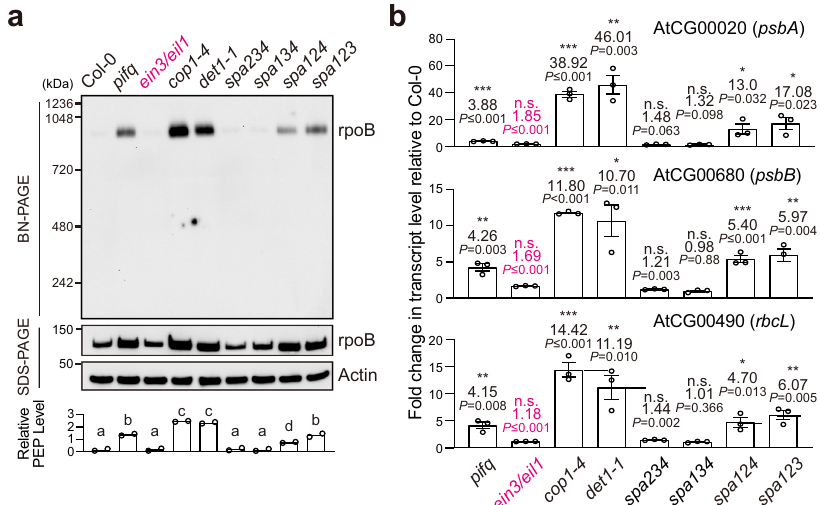
Fig. 1 | The PEP is constitutively activated in all de-etiolated mutants except ein3/eil1 . a Immunoblots showing the levels of the PEP complex in 4-d-old dark- grown seedlings of Col-0, pifq , ein3/eil1 , cop1-4 , det1-1 , spa 234 , spa 134 , spa 124 , and spa 123 .Totalproteinwasisolatedundereithernativeordenaturingconditionsand resolved via blue-native or sodium dodecyl sulfate polyacrylamide gel electro- phoresis(BN-PAGEorSDS-PAGE)toassessthefractionofrpoBinthePEPcomplex or the amount of total rpoB by immunoblots, respectively. The bar graph shows the quali fi cation of the relative levels of the PEP complex, which were calculated using the relative level of rpoB in the PEP complex (BN-PAGE) divided by the relative level ofthe total rpoB (SDS-PAGE)in each sample.Different letters denote statistically signi fi cant differences in the relative PEP levels among the genotypes